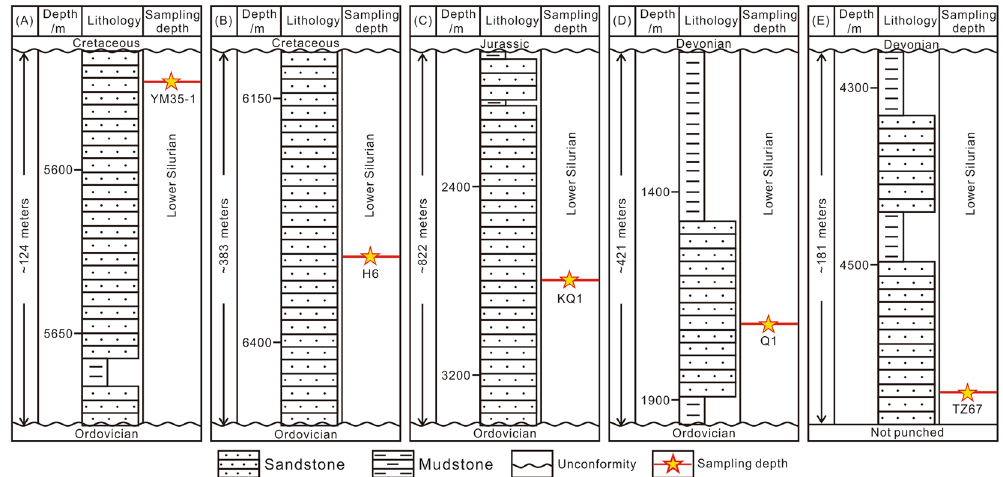
Figure 3. Strata histograms showing the sampling depth in each drillhole. ( A ) YM35-1; ( B ) H6; ( C ) KQ1; ( D ) Q1; and ( E ) TZ67.